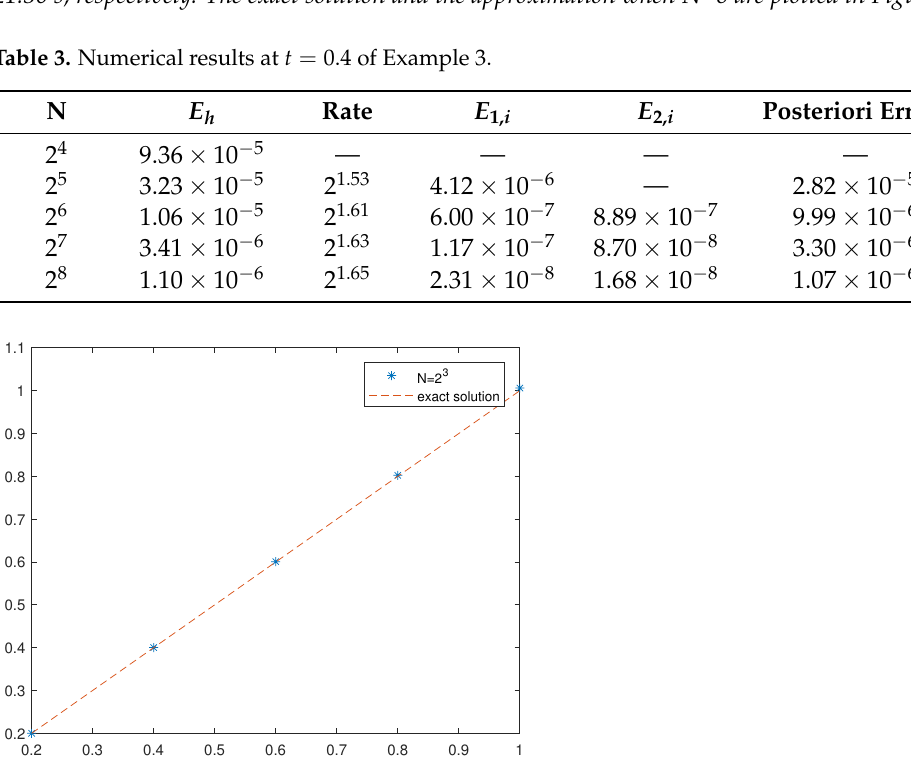
Figure 1. The absolute errors and the approximations when N = 2 3